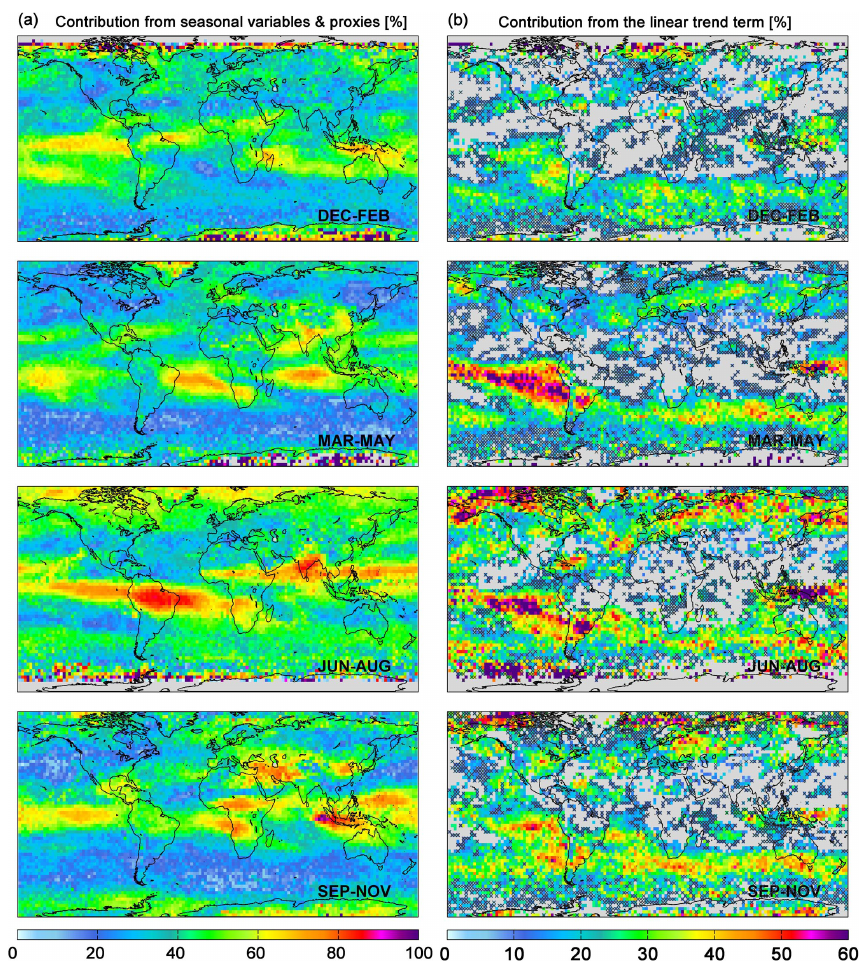
Figure 2. Seasonal distributions of the contribution from the seasonal and explanatory variables into the IASI O 3 variations estimated as " (cid:3)! # 4 ; m (cid:2) a (cid:3)(cid:2) cos (nωt) ; sin (nωt) ; X P /σ ( O 3 (t)) 100 × σ (in percent, a ) and of the contribution from the linear trend n ; b n ; x j norm , j (t) n = 1 ; j = 2 calculated as (cid:2) 100 × σ (cid:0) x j = 1 · trend (cid:1) /σ ( O 3 (t)) (cid:3) (in percent, b ). The grey areas and crosses refer to the non-significant grid cells in the 95% confidence limits (2 σ level). Note that the scales are